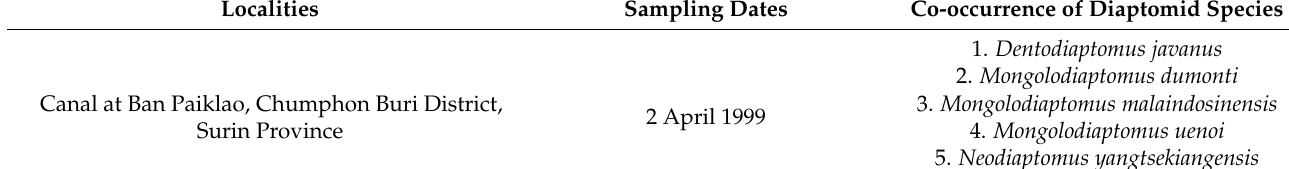
Table 3. Co-occurrences of up to 7 species of diaptomid copepods in freshwater habitats in Northeast Thailand. Localities Sampling Dates Co-occurrence of Diaptomid